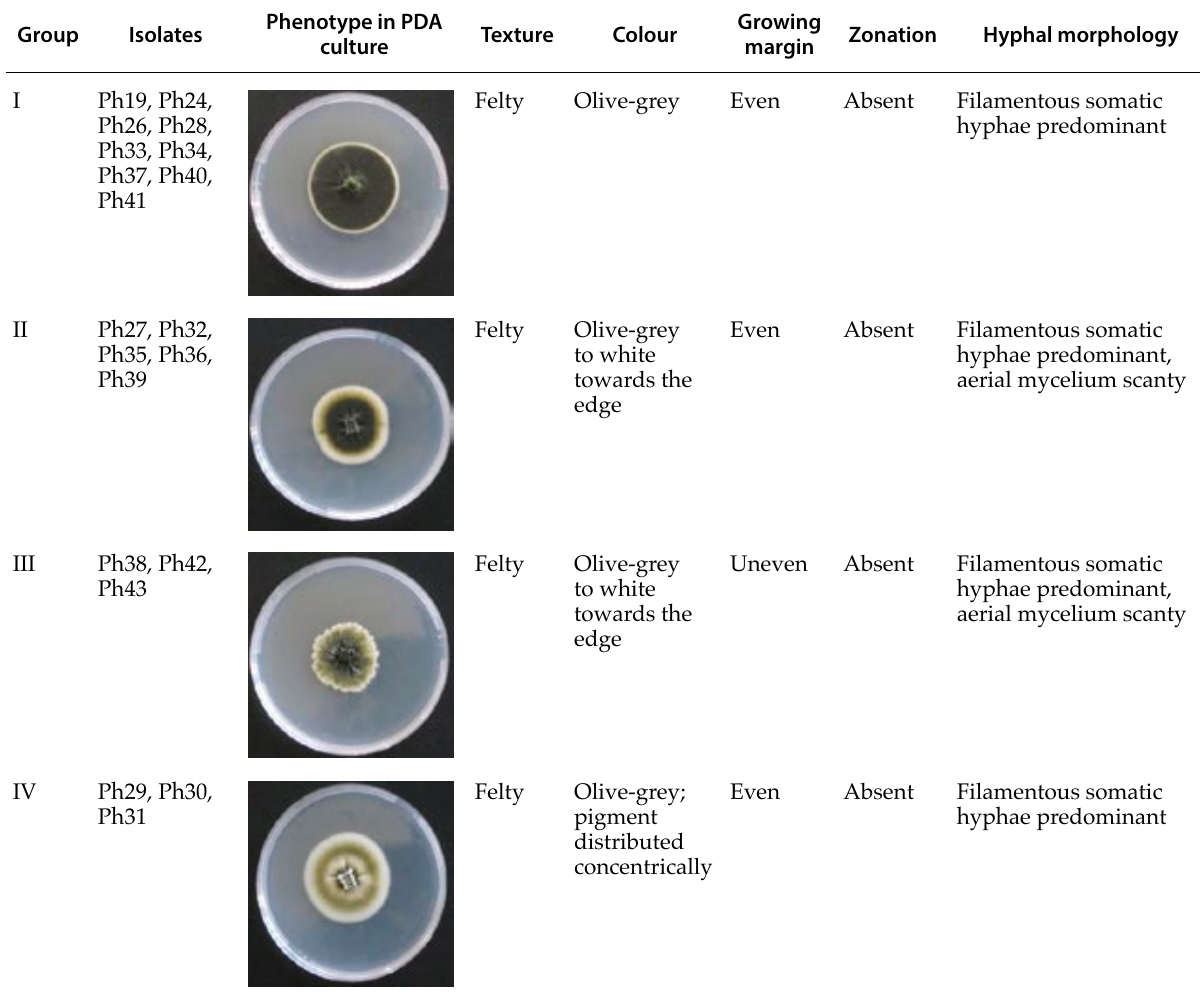
Table 4. Distribution of the twenty Phaeomoniella chlamydospora isolates among the four morphological groups according to several phenotypic characteristics for each group (after 15 days at 25⁰C in PDA).